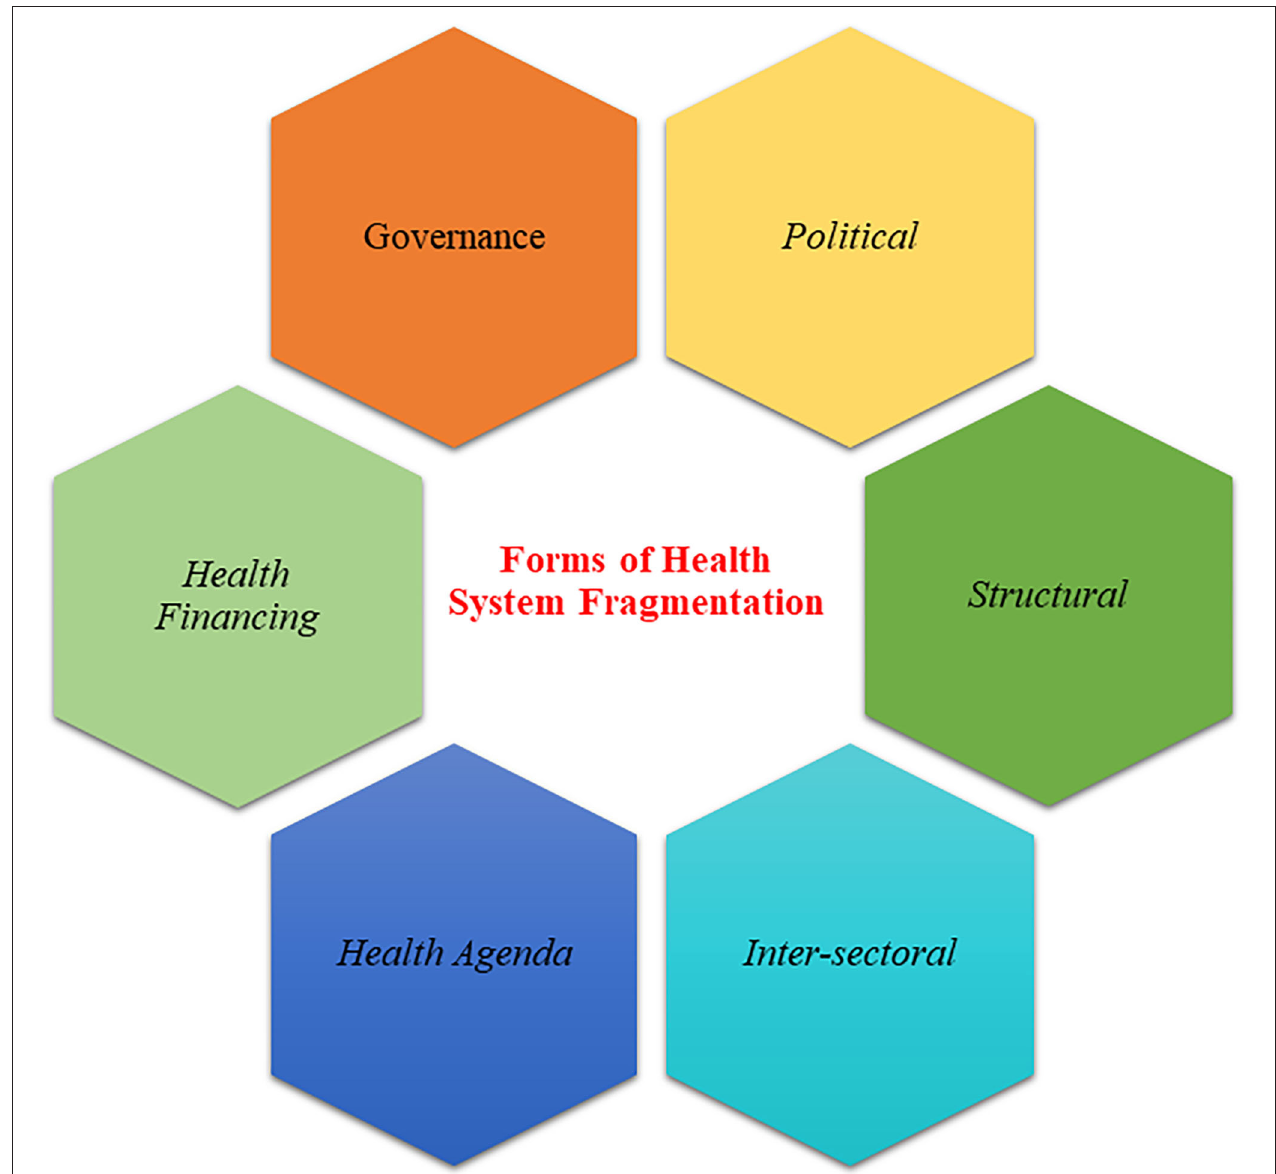
FIGURE 1 | Health system fragmentation forms in